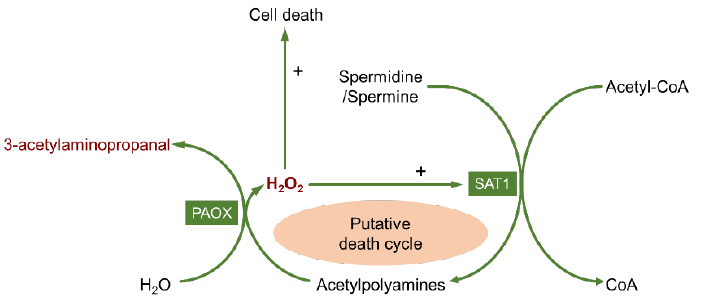
Figure 3. The key role of H 2 O 2 in the positive cell-death-signal-generating cycle via the action of SAT1 and PAOX. Adapted with permission from ref. [38]. Copyright 2003 Wallace,